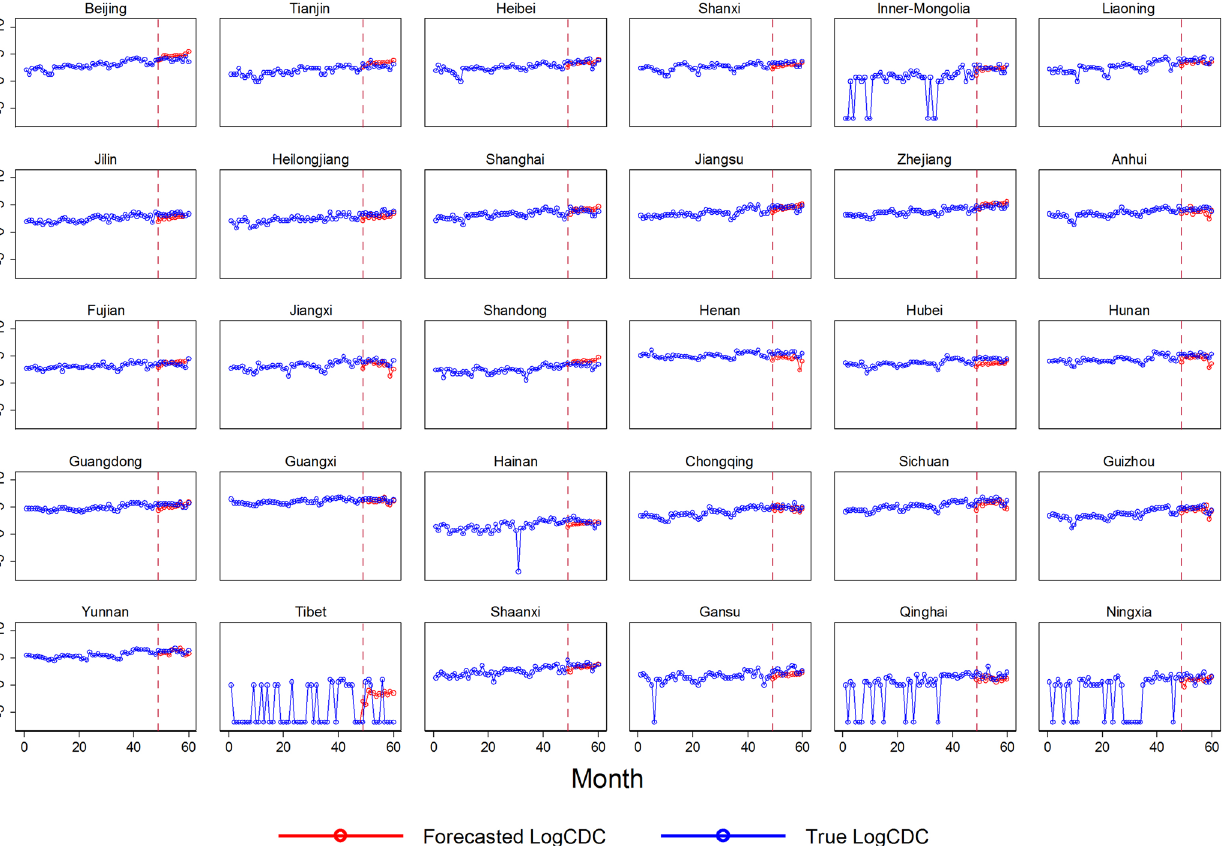
Figure 5. Forecasted log CDC . The forecasting is conducted in low and high HIV/AIDS prevalence areas respectively; high prevalence areas include Anhui, Jiangxi, Henan, Hubei, Hunan, Guangdong, Guangxi, Chongqing, Sichuan, Guizhou and